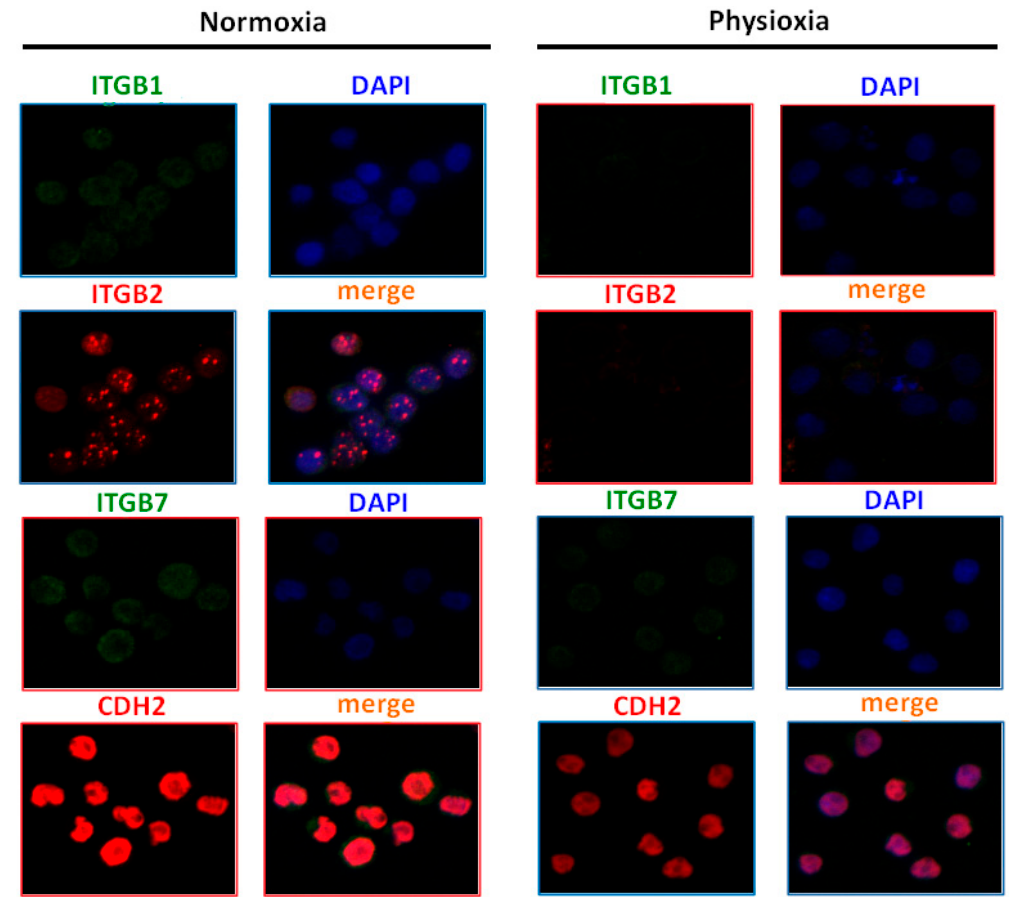
Figure 10. Confocal microscopy images of U2904 cells expressing cellular adhesion molecules (CAMs) under normoxia and physioxia. Cells were preincubated in normoxia and physioxia for 72 h and stained with anti-ITGB1, anti-ITGB2, anti-ITGB7, anti-CDH2, and a nuclei probe (DAPI). Magnification at 63× and zoom in.